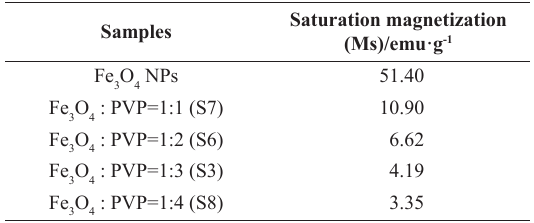
O /PVP 3 4 O /PVP 3 4